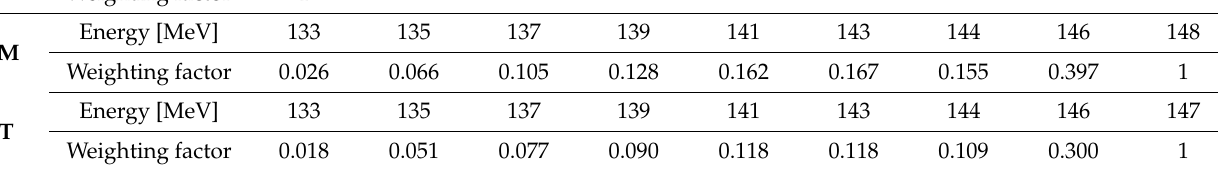
1E : Figure 1b shows the distal-edge tracking with only one proton energy. The dose is longitudinally heterogeneous. It is the extreme case of irradiation by only using a single Bragg peak of 146 MeV protons from each side. Due to the overlay from the two opposing directions, the dose minimum, D t, is obtained in the middle of the tumor and at the very edges of the tumor, while higher doses are obtained at any other position in the tumor with a dose maximum of about 1.74 · D t at a distance of 3 mm from the tumor edges . HOM: Figure 1c shows the distal-edge tracking with proton energies that all have a range such that the single Bragg peaks are in the distal half of the tumor. The depth-dose curve when applied for one direction does not homogeneously cover the tumor. However, the single Bragg peaks are weighted such that the irradiation from two opposite directions lead to a homogeneous depth dose with the same low longitudinal fluctuation as in the (cid:12) (cid:12) D HOM (cid:12) (cid:12) < 1.0%) within the tumor. SOBP case ( (cid:12) (cid:12) D t OPT: distal-edge tracking with proton energies that also have a range such that the single Bragg peaks are in the distal half of the tumor (Figure 1d). In contrast to the HOM irradiation mode, the longitudinal dose distribution is no longer homogeneous. It is taken for optimized cell survival in the healthy tissue for the two-sided, interlaced proton minibeam irradiation. It allows the maximizing of the center-to-center distance of the planar proton minibeams under the constraint that D > 0.975 D t , where D t = 10 Gy, at every location within the tumor volume.